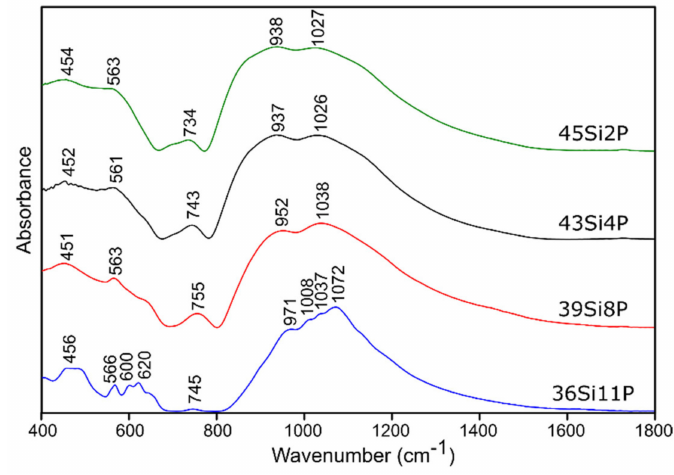
Figure 4. MIR spectra of the pure silicate–phosphate glass samples.